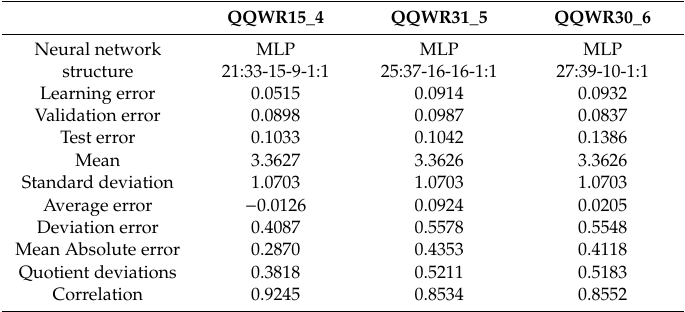
Table 3. The quality and structure of the neural models produced.